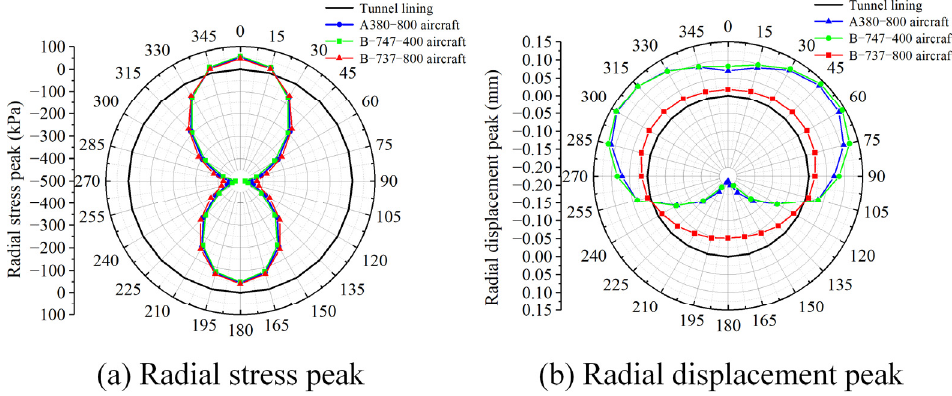
Figure 9. A radial stress and displacement peak diagram of the tunnel structure.